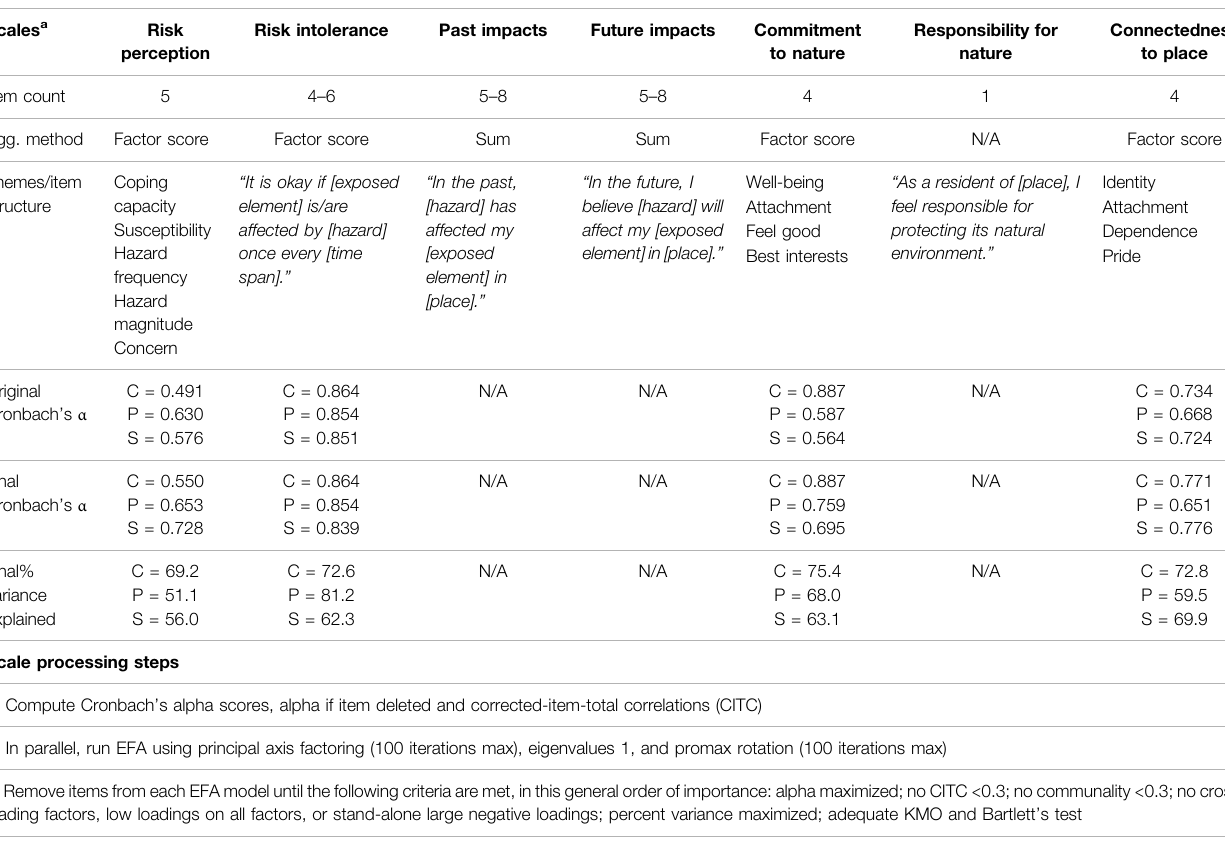
TABLE 2 | Composition and computation of variable scales. For scales composed of 1 – 9 Likert items, processing and reliability testing was conducted by assessing Cronbach ’ s alpha ( α ), corrected-item-total correlations (CITC), and exploratory factor analysis (EFA) using principal axis factoring. The “ original ” Cronbach ’ s α is a measure of the internal reliabilityof all scale items per site (C (cid:1) Catterline, P (cid:1) Puruvesi, and S (cid:1) Spercheios), while the “ fi nal ” Cronbach ’ s α results from removing items from the scales to increase their reliability, based on the processing steps described. Factor scores using weighted averages were calculated for further